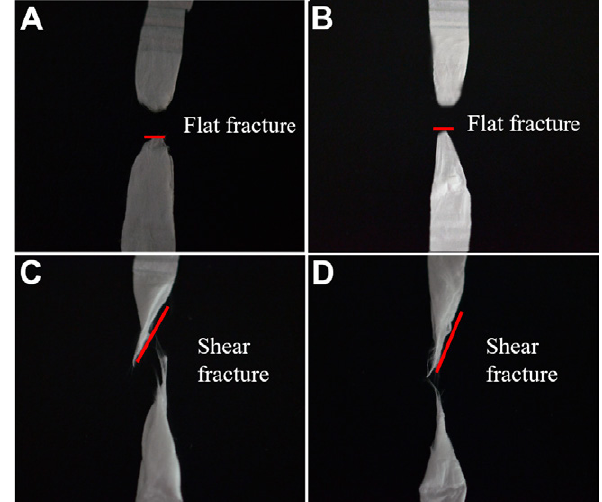
Figure 12: Fracture morphology of PAN nanofiber members with different structures: A) 0 ∘ B) 0 ∘ /90 ∘ C) 0 ∘ /90 ∘ /+45 ∘ D) 0 ∘ /90 ∘ /+45 ∘ / − 45 ∘ .